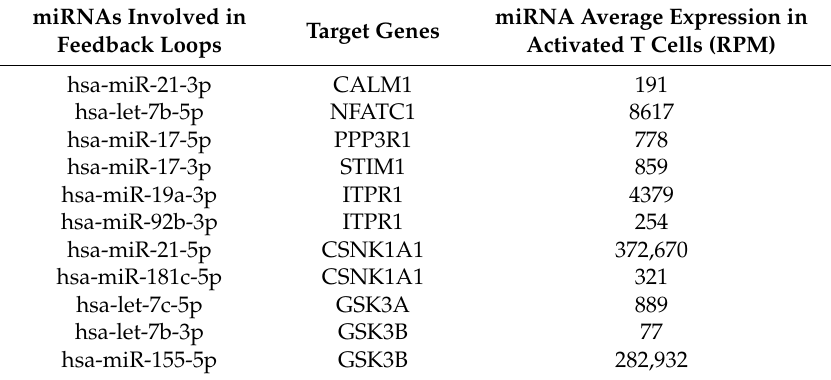
Table 2. List of miRNAs potentially involved in a feedback loop to modulate the calcineurin/NFAT signaling pathway. Eleven miRNAs are identified in this study to be involved in a feedback loop with target genes and expression in human activated T cells. miRNA Average Expression in miRNAs Involved in Target Genes Activated T Cells (RPM) Feedback Loops hsa-miR-21-3p CALM1 191 hsa-let-7b-5p